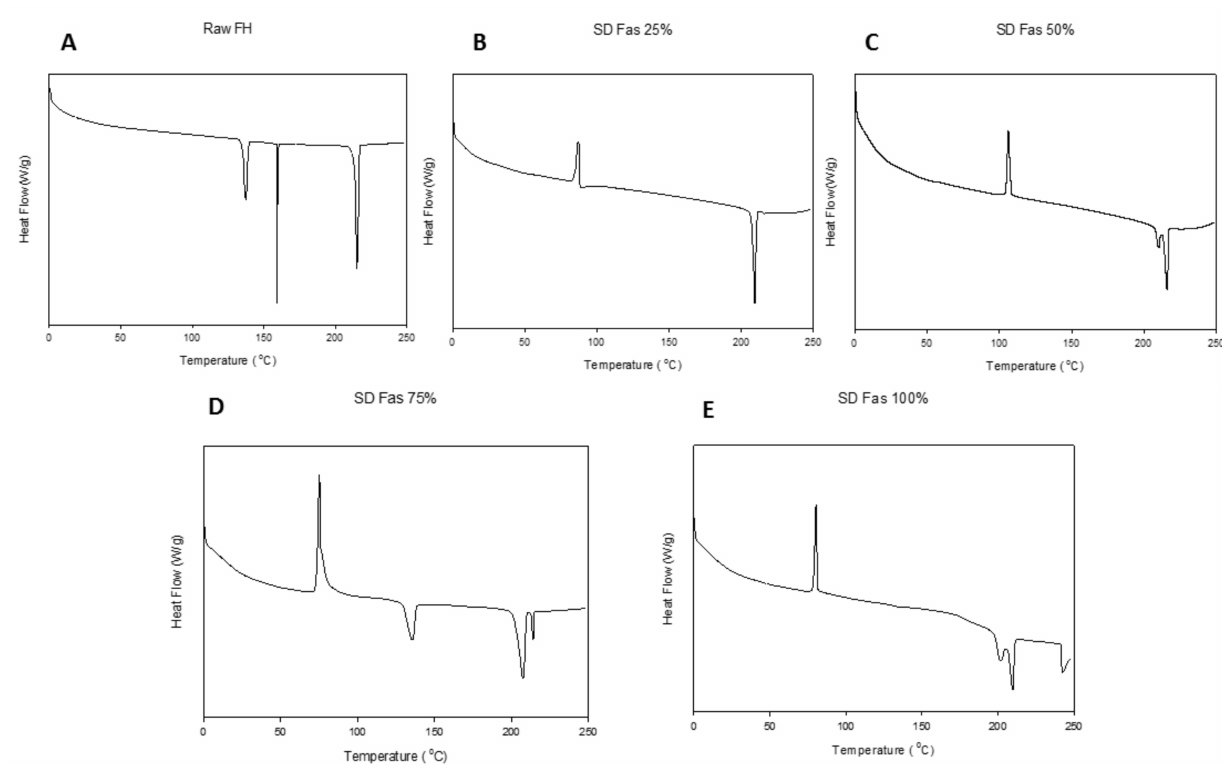
Figure 5. DSC thermograms of Fasudil: ( A ). Raw FAS; ( B ). SD FAS 25% pump rate; ( C ). SD FAS 50% pump rate; ( D ). SD FAS 75% pump rate; and ( E ). SD FAS 100% pump rate. (Exotherm: upward and Endotherm: